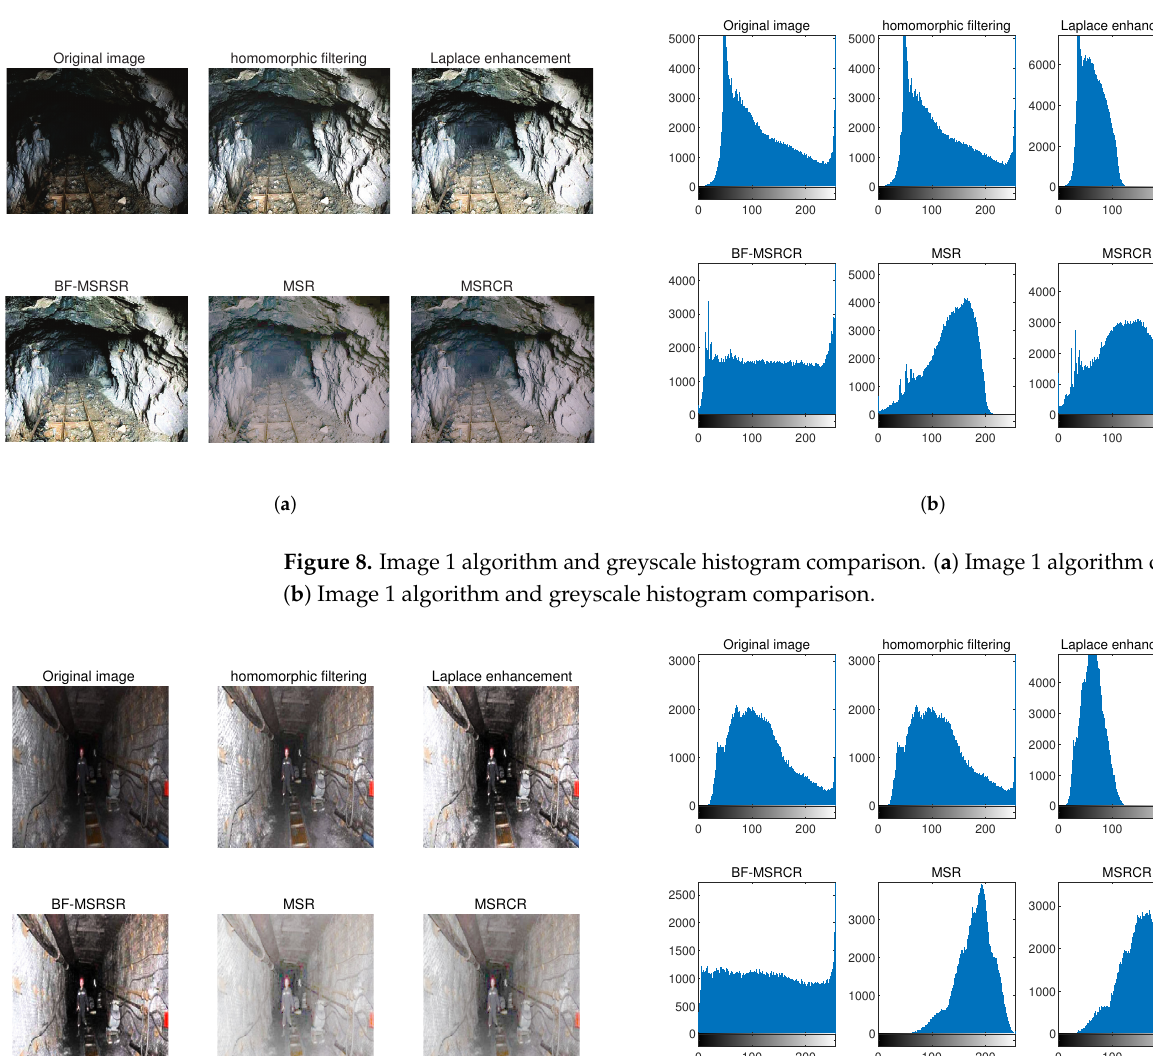
Figure 7. Images used in the experiment. ( a ) downhole image 1; ( b ) downhole image 2; ( c ) downhole image 3.